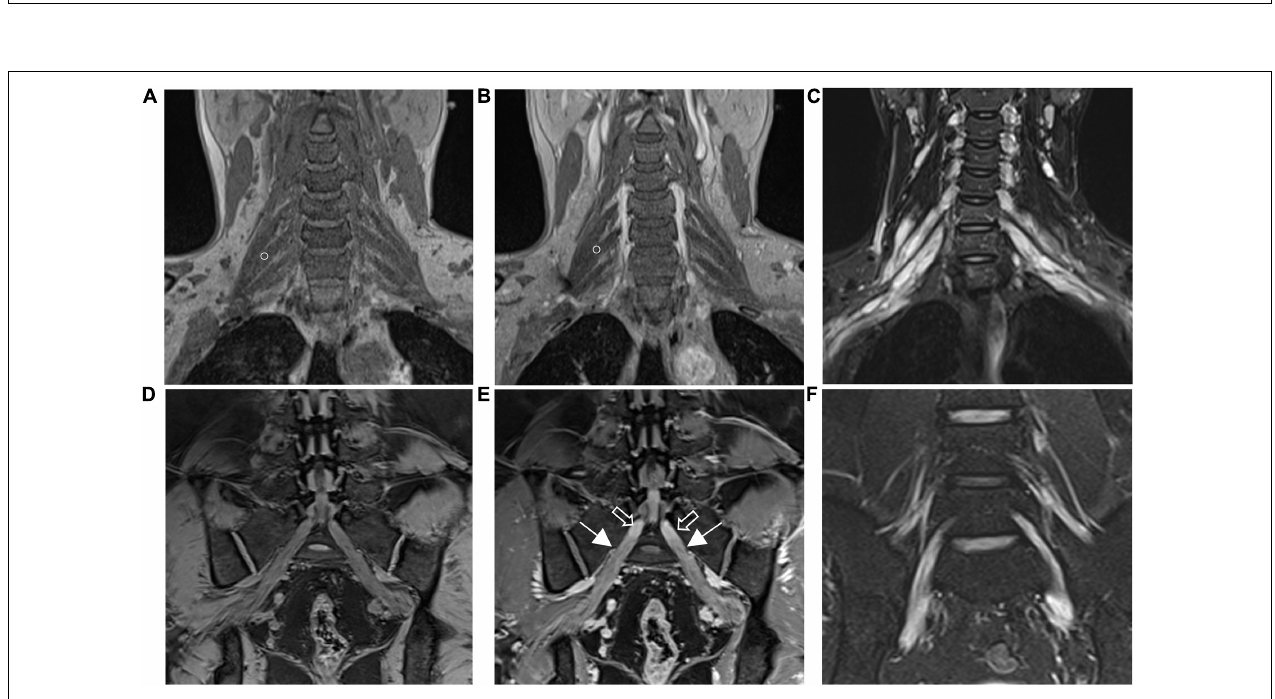
FIGURE 2 | The brachial (A,B) and lumbosacral (D,E) plexus on non-contrast-enhanced volumetric interpolated breath-hold examination (VIBE) (A,D) and contrast-enhanced VIBE sequences (B,E) , respectively. Images show the right C7 nerve root with absence of enhancement (circles in A,B ). Bilateral S1 nerve roots demonstrate obviously enhanced (arrows in E ) and vividly enhancing ganglia (hollow arrows in E ). Images on turbo inversion recovery magnitude (TIRM) show a striking increased T2 signal intensity in the brachial (C) and lumbosacral (F) plexus. The CR, ce nSNR/non-ce nSNR; SNR, nerve signal intensity/background noise; ce, contrast-enhanced; nT2, nerve root T2 signal intensity/adjacent muscle T2 signal